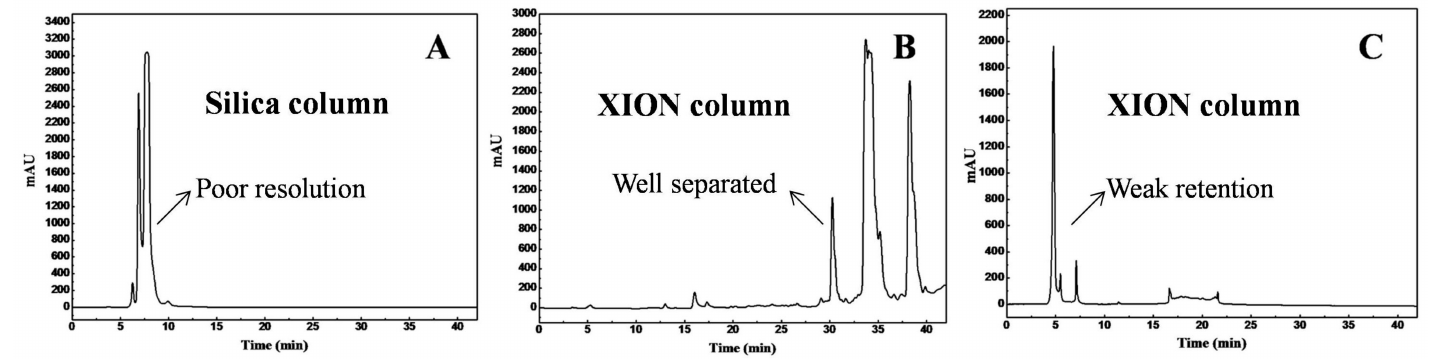
Figure 1. Representative analytical chromatograms of S. prattii crude extract on a silica analytical column ( A ) and XION analytical column ( B , C ). The conditions of ( A , B ) were the same: mobile phase A: n -hexane, and mobile phase B: ethanol; gradient: 0–8.4 min, 0% B; 8.4–16.8 min, 5%~5% B; 16.8–25.2 min, 10%~10% B; 25.2–33.6 min, 20%~20% B; 33.6–42 min, 30%~30% B. Conditions of ( C ): mobile phase A: 0.2% v / v formic acid in acetonitrile, and mobile phase B: 0.2% v / v formic acid in water; gradient: 0–10 min, 0%~0% B; 10~56 min, 0%~95% B. The other conditions were the same: monitoring wavelength: 254 nm; flow rate: 1 mL/min; injection volume: 10 µ L; column temperature: 25 ◦ C.